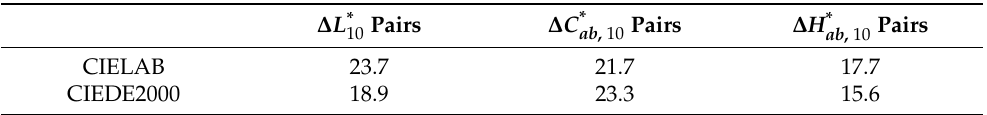
Table 1. STRESS values in CIELAB and CIEDE2000 units of the 42 pairs with predominant ( ≥ 85%) lightness, chroma, and hue-differences (Experiment I).